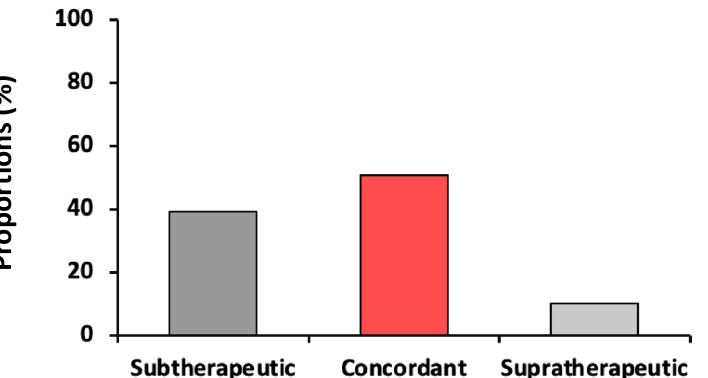
Figure 2. Description of concordance and discordance of anti-FXa and aPTT. Both variables were measured on the same sample. Observed aPTT values were considered concordant if they felt into the expected aPTT range that corresponds to the anti-FXa range of 0.3 to 0.7 IU/mL. In a mixed linear regression model, anti-FXa was associated with aPTT, with an esti- mated regression coefficient of 0.43 10 − 2 IU/mL (95% CI, 0.41 to 0.45) per 1 s increase in aPTT, p < 0.001. As shown in Figure 3, this relationship was significantly modulated by all co-variables (the time courses are shown in Figure S2). Increase in fibrinogen, factor V, and platelet levels strengthened this association whereas increase in PT and bilirubin weakened the association.